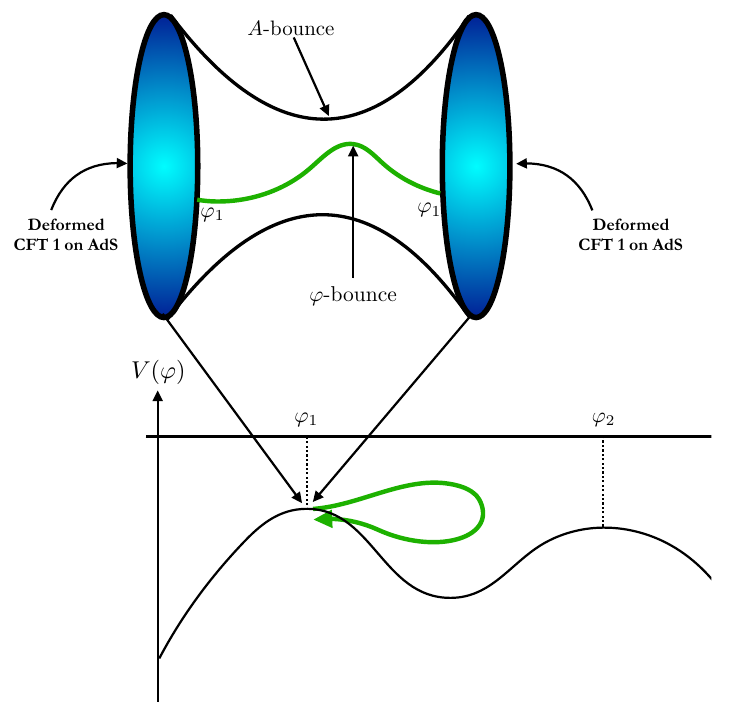
Figure 4 . Wormhole connecting two versions of the same CFT living at one maximum of V ( ϕ ) . The solution has one A -bounce and one ϕ